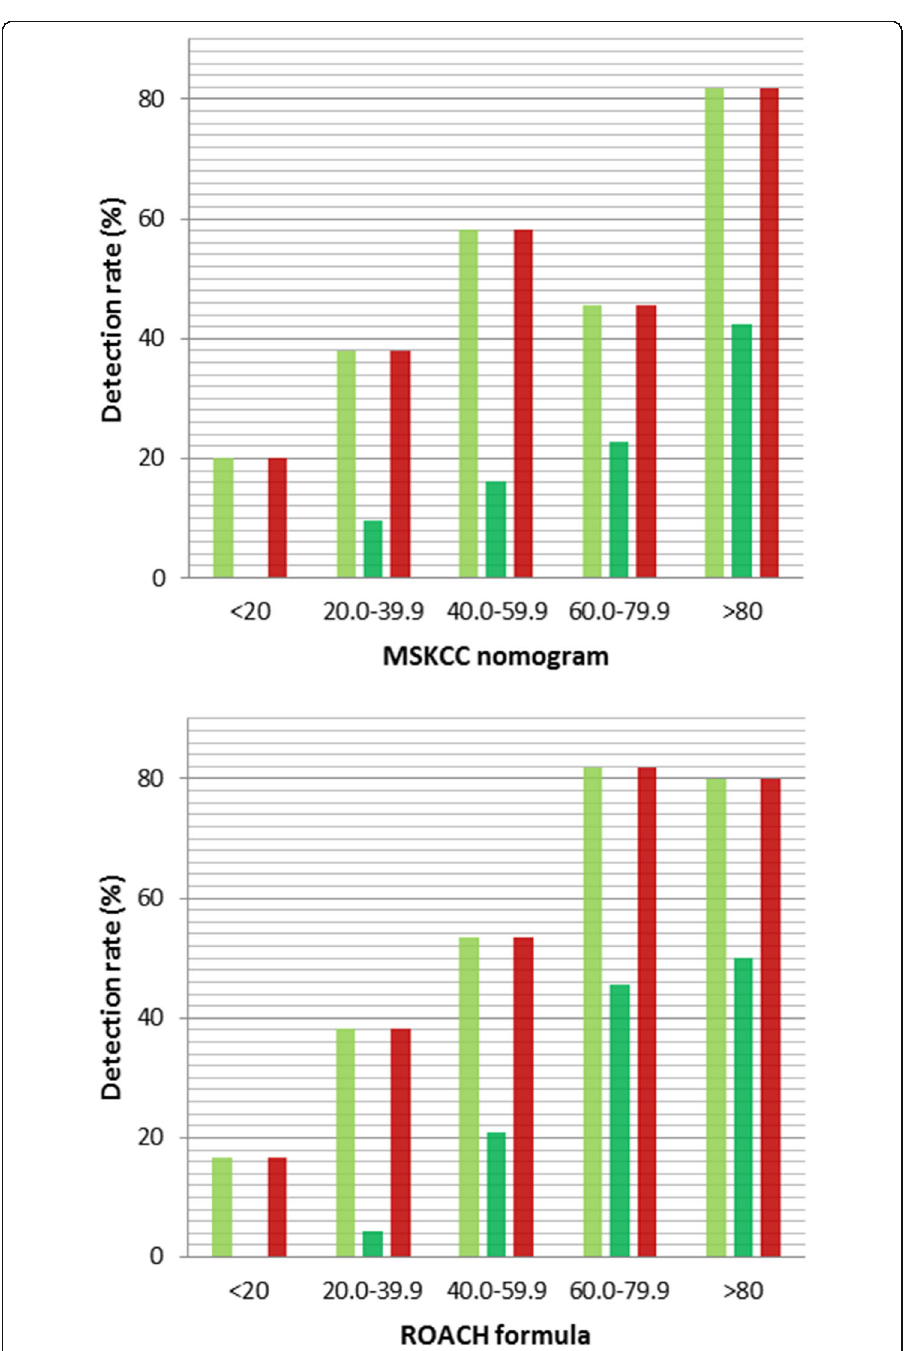
Fig. 3 Detection rate of 18 F-DCFPyL PET/CT in relation to risk on lymph node metastases according to the MSKCC nomogram and ROACH formula at different anatomical localisations. Locoregional lymph nodes (light green), distant lymph nodes (dark green) and both locoregional and distant lymph nodes